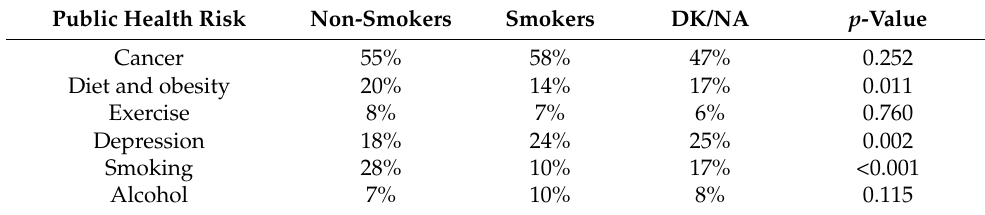
Figure 5. Importance of public health risks by smoking status. Table 7. Most important public health risk (up to 3 answers per participant) by smoking